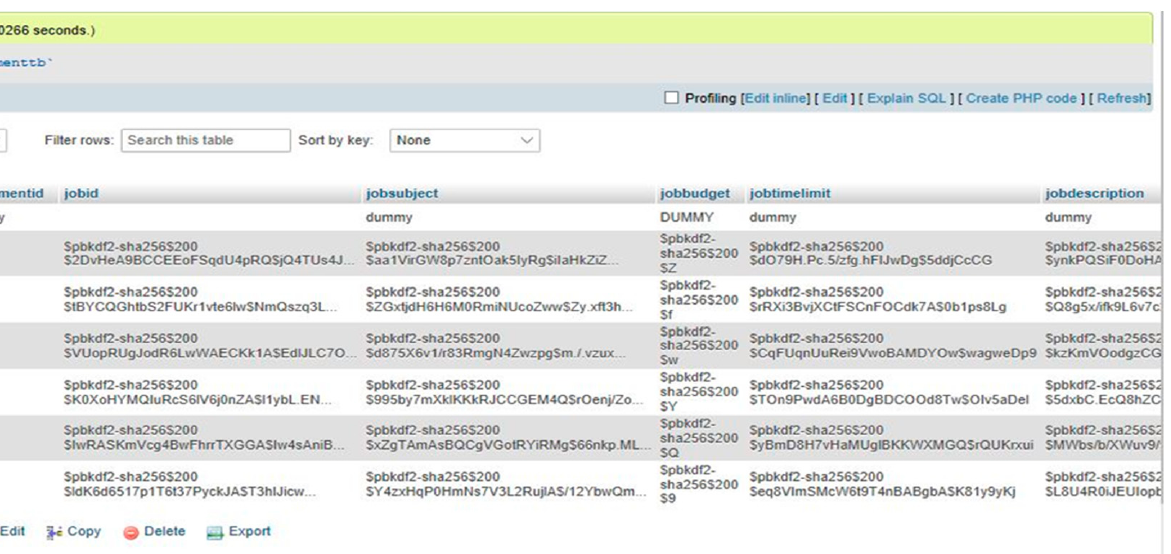
Figure 19. Storage of job details mentioned on the smart contract form in a hashed format.